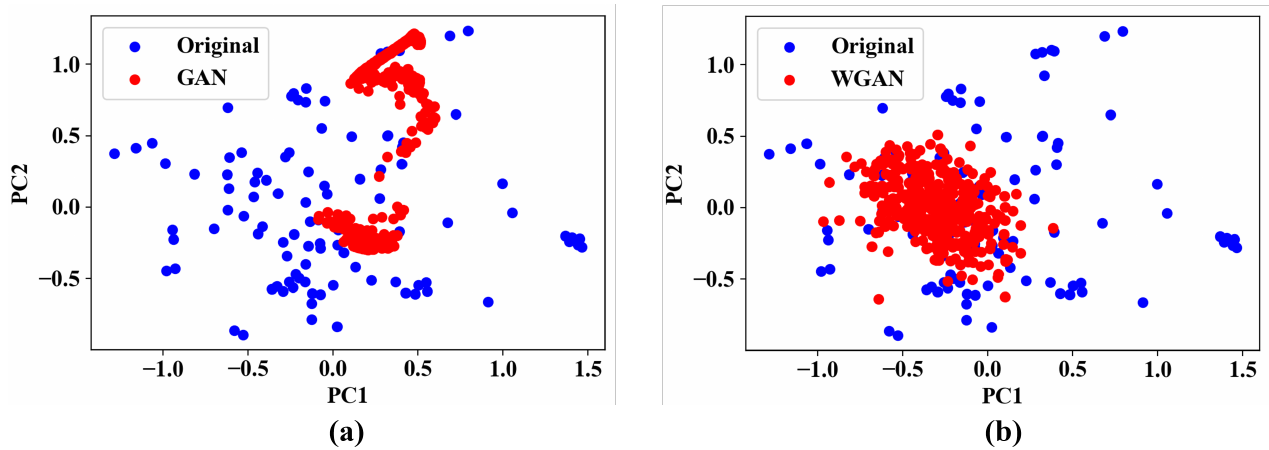
Figure 4. Distribution of data samples generated by ( a ) GAN and ( b )